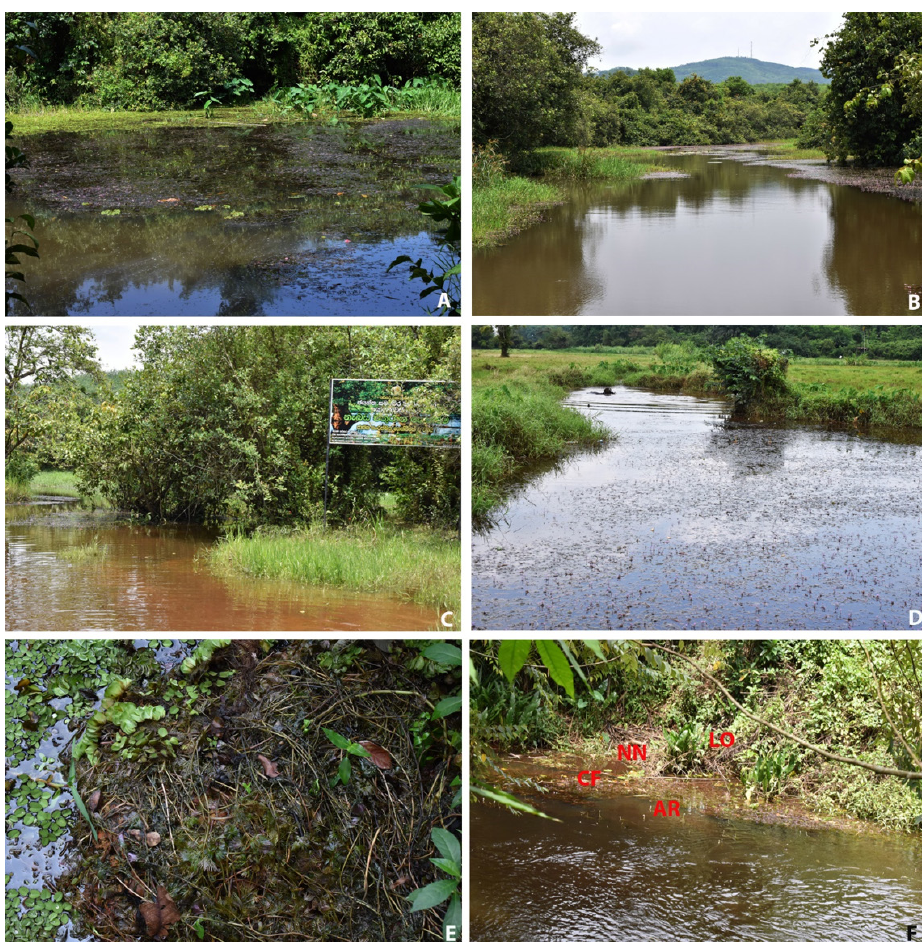
Figure 4: Sampling sites in Neboda area. A. and B. Main stream infested with C . furcata; C.The infested mainstream runs through the Neboda Waturana wetland; D. A large pool, full of C . furcata growth, that occurs at the confluent area of substream 2 with the mainstream. Note the buffalos confined to the farther end of the pool; E. Cabomba furcata co-existing with Salvinia molesta in the mainstream and F. The area where the mainstream joins the ‘Kalu Ganga’. Note the occurrence of the few remaining endemic and native plant species with C . furcata (CF); Aponogeton rigidifolius (AR), Lagenandra ovata (LO) and Nymphaea nouchali (NN). Note the types of the population, linear dispersion (B) and clump dispersion (D).